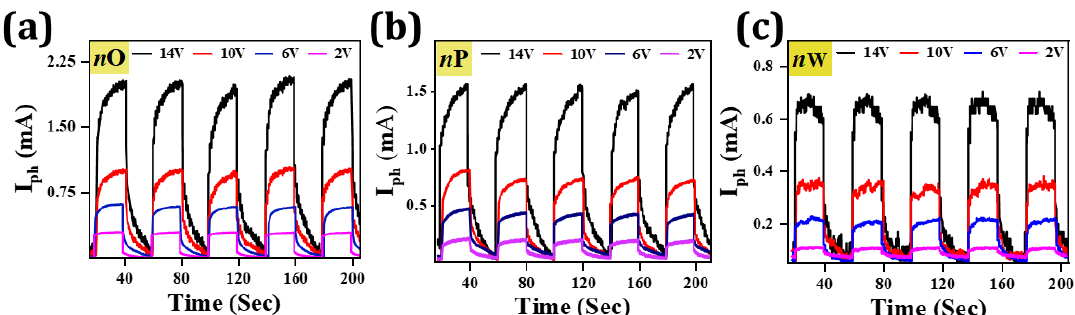
Figure 6. Bias-dependent I − T for ( a ) nO, ( b ) nP, and ( c ) nW under 225 µW optical power .